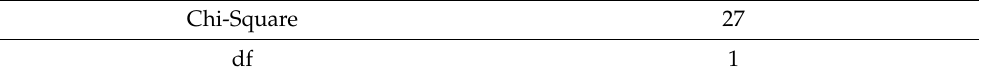
Table 9. Chi-square test value for the variables “mass media” and “performance athlete profile.”